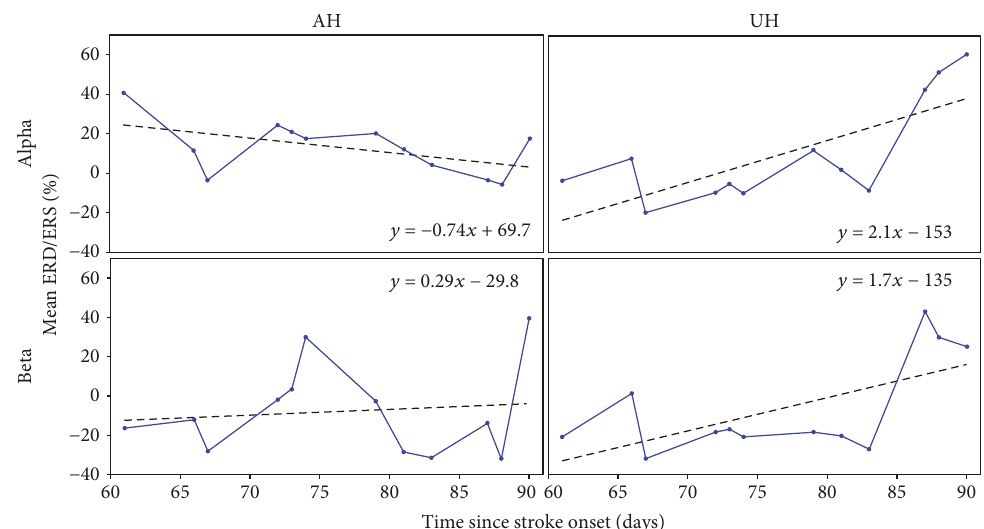
Figure 4: Example of linear trends, computed from average ERD/ERS across sessions and taking into account days since stroke onset. Slopes were calculated from central channels of the AH and UH of patient P 5 . Trends were computed separately for alpha and beta bands. Table 3: Slopes of ERD/ERS computed for each patient in the alpha band and for each AH ( F C z , and P z ), and UH ( F C T P UH , UH , UH , and UH ) channels. Slopes computed from ERD/ERS with a signi since stroke onset ( ∗ ) are